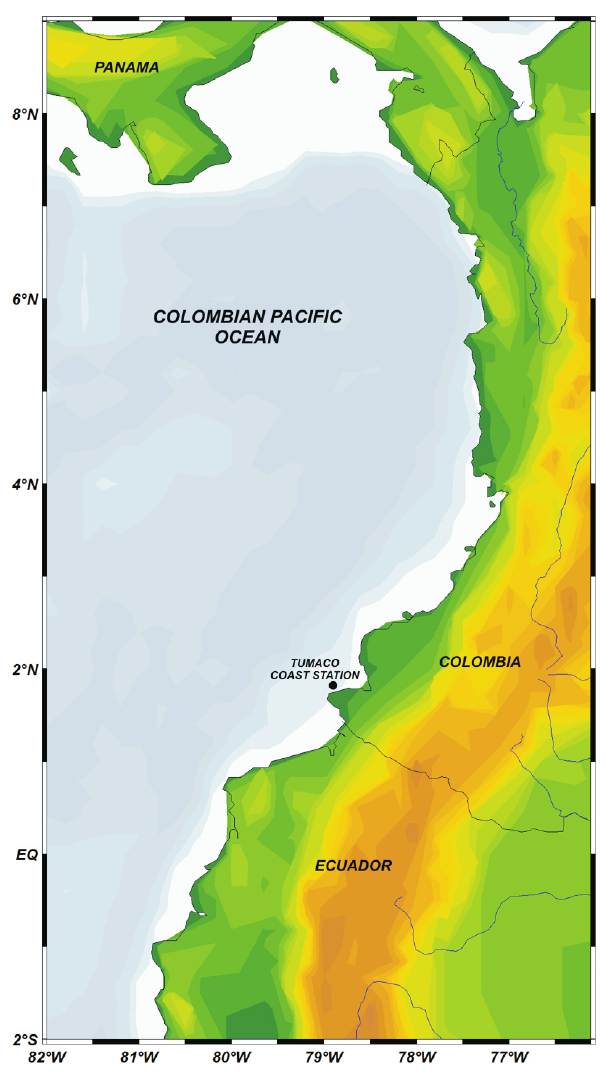
Fig. 1. Map of the study area and location of Tumaco coastal station.